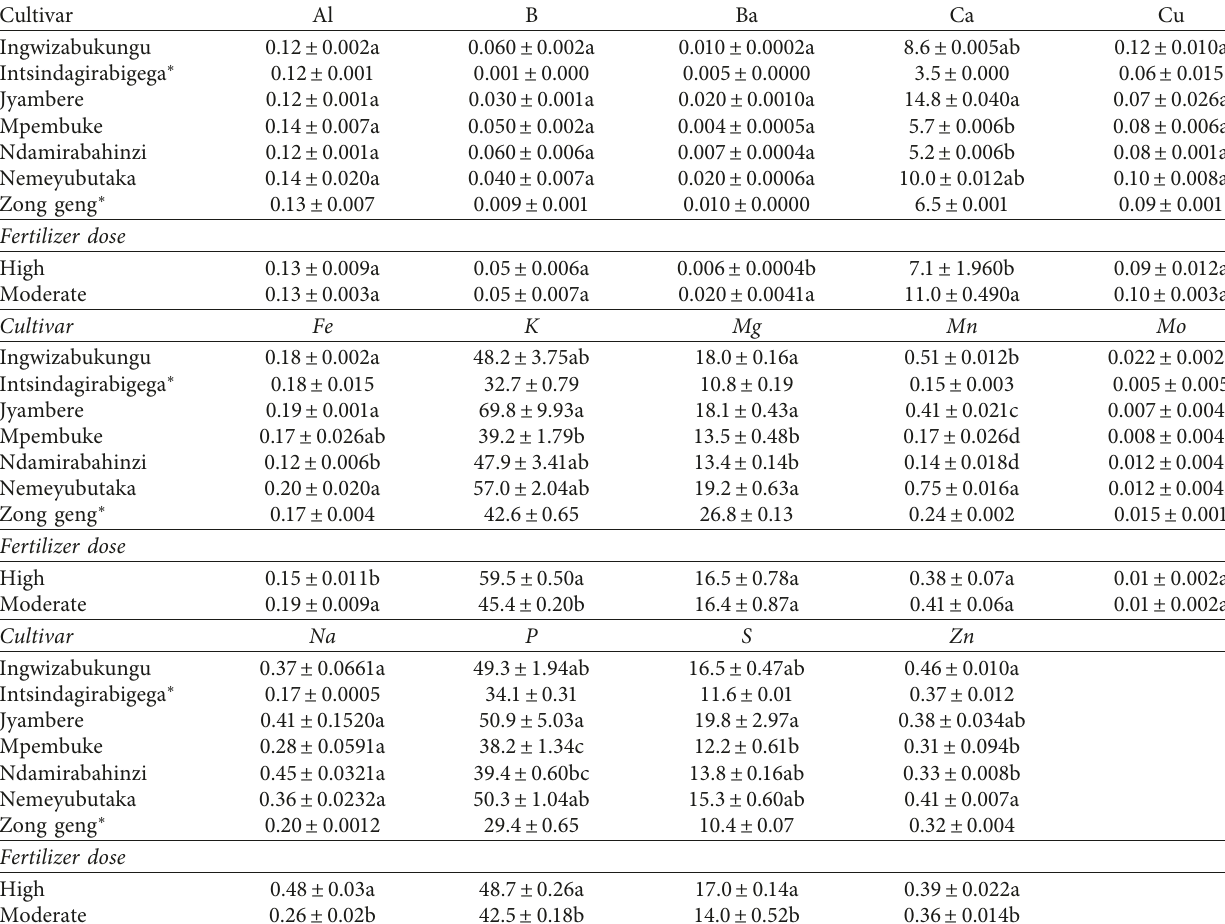
Table 2: Mean mineral element content (mg · kg − 1 dry weight) (10 2 ) in Rwandan rice